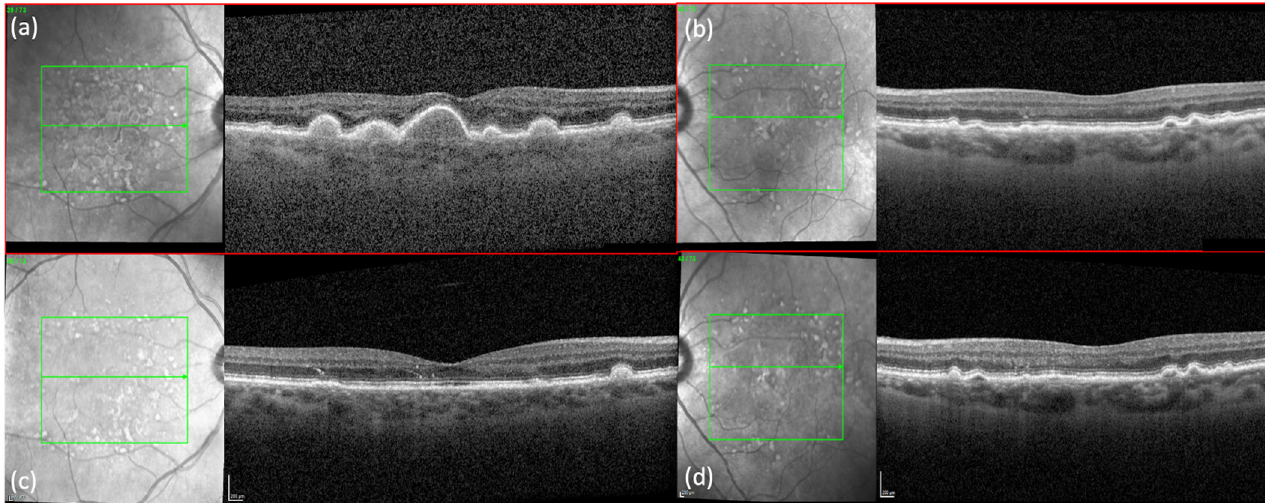
Figure 1. SPECTRALIS ® Heidelberg OCT B-scans showed ( a ) presence of several large central, soft, confluent drusen in the right eye and ( b ) collapsed PED and subretinal material without fluid in the left eye. One year later, follow-up B-scan of the ( c ) right eye showed dramatic, complete drusen regression centrally, without geographic atrophy or choroidal neovascularization. ( d ) Corresponding follow-up B-scan of the left eye showed no changes.